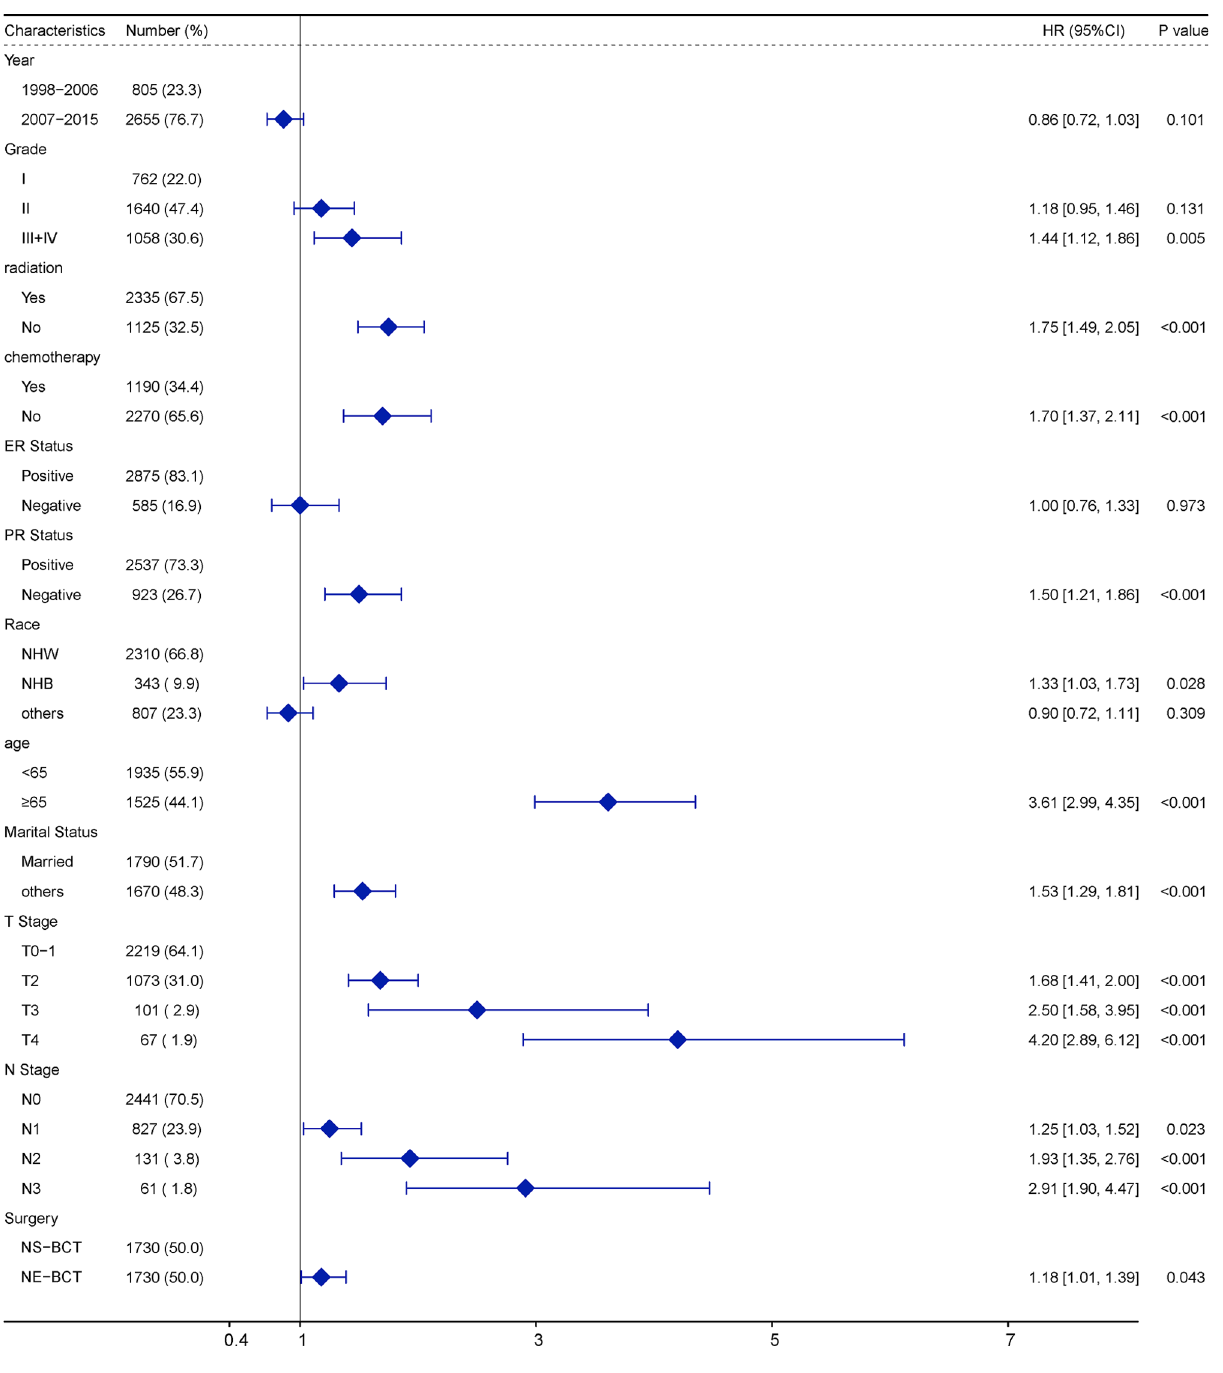
FIGURE 3 | Multivariate Cox regression model forest